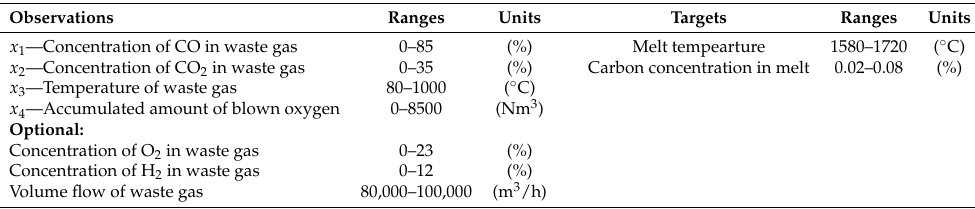
Table 2. Dynamic observations and targets with measurement